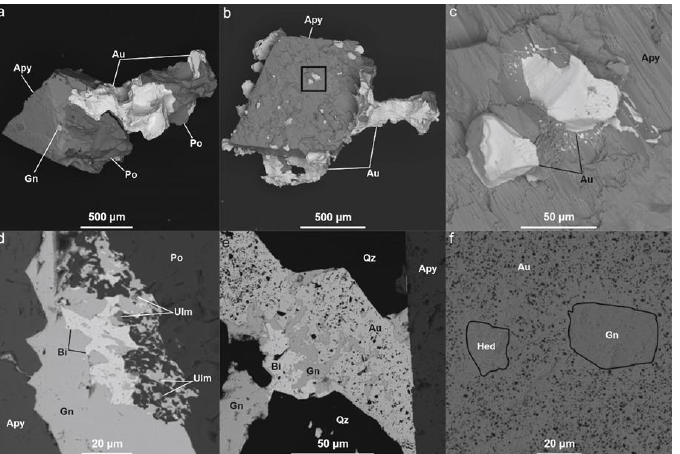
Figure 3. Ore associations of the Dobroe deposit: ( a ) intergrowth of arsenopyrite (Apy), crystal of pyrrhotite (Po) and gold (Au); ( b ) gold inclusions in arsenopyrite crystal; ( c ) enlarged area from ( b ); ( d ) intergrowths of galena (Gn), native bismuth (Bi), and ulmanite (Ulm) at the contact of pyrrhotite and arsenopyrite; ( e ) gold-bismuth-galena aggregate at the boundary of arsenopyrite and quartz (Qz); ( f ) inclusions of hedleyite (Hed) and galena (the contours of the inclusions are highlighted) in native gold. The fineness of native gold varies from 838 to 913‰, with an average value of ~900. The main impurity element is silver. The silver contents of gold of the galena-bismuth and pyrrhotite-arsenopyrite associations do not differ significantly; however, a decrease in the silver content (from ~10 wt.% to ~8 wt.%) of gold following contact with galena was